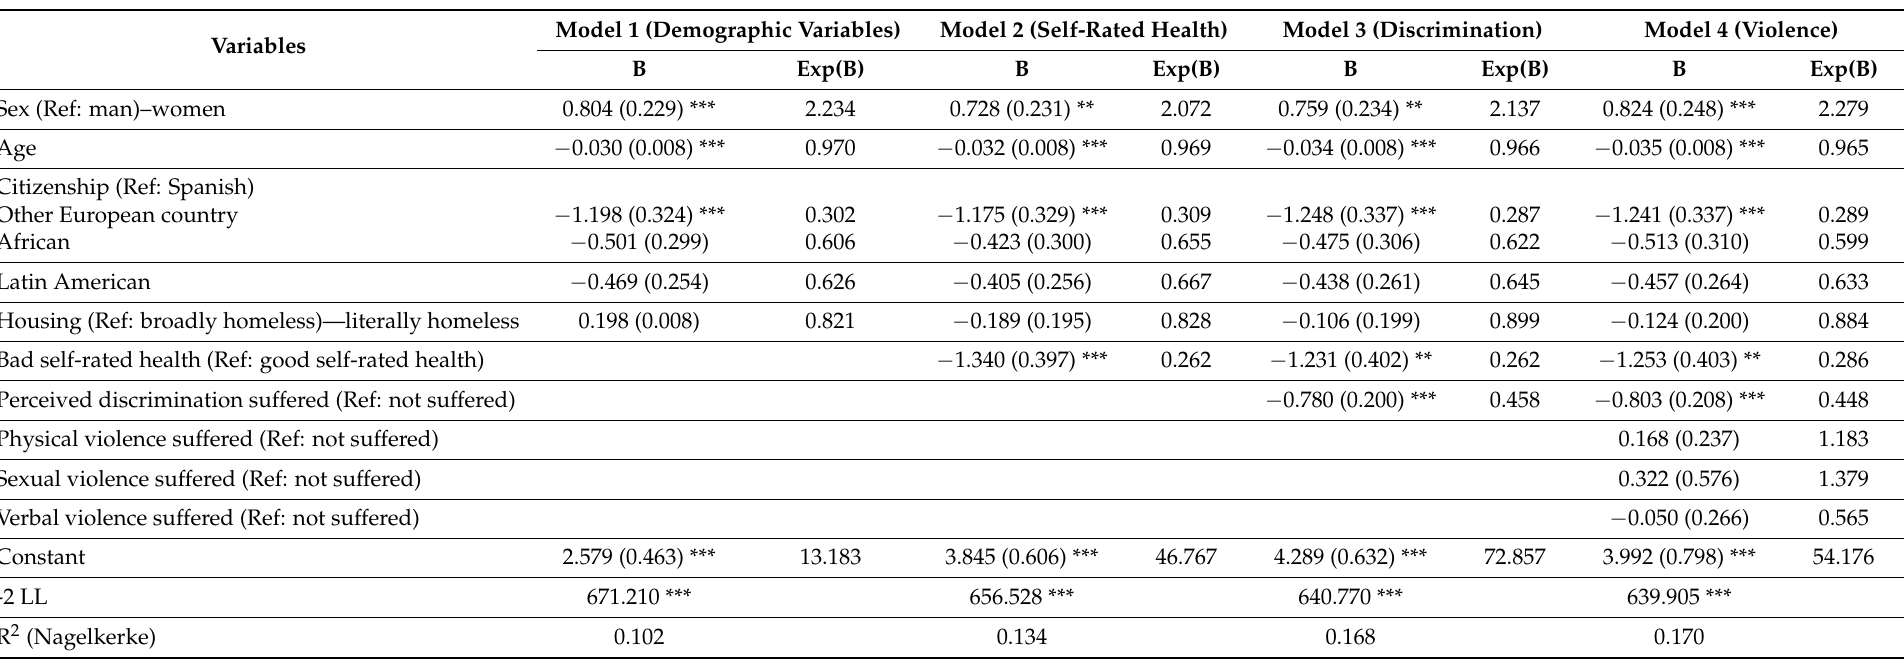
Table 6. Summary of logistic regression